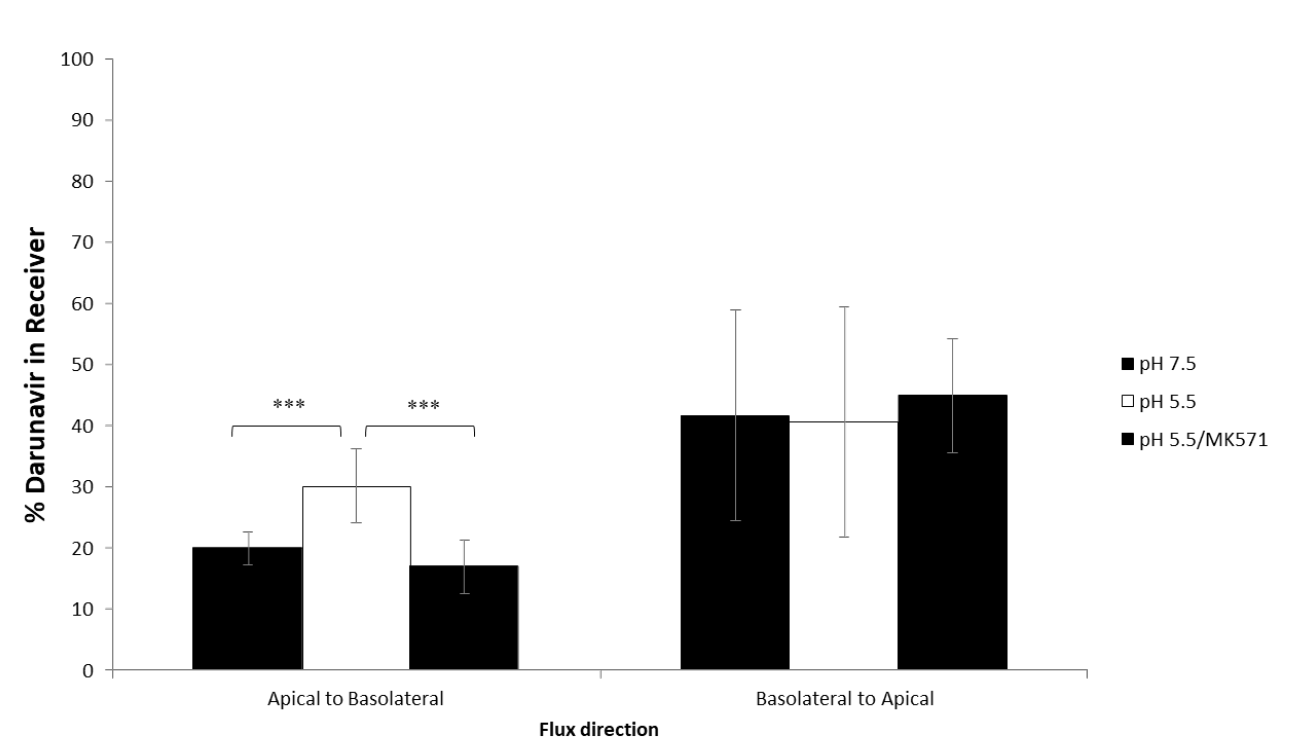
Figure 3. Transcellular permeability of darunavir across an HEC-1A monolayer cultured at pH 7.5 or pH 5.5. The apical to basolateral and basolateral to apical permeability of darunavir across HEC-1A monolayers cultured at pH 7.5 or 5.5 in the apical compartment is shown. The apical to basolateral and basolateral to apical permeability of darunavir in the presence of the MK571 inhibitor across HEC-1A monolayers cultured at pH 5.5 is shown in comparison with permeability at pH 7.5 or 5.5 without inhibitor. Data is presented as % applied darunavir permeated into the receiver chamber as the mean ± SD ( n = 10). Statistical analysis performed was a one-way ANOVA using Bonferroni post-hoc test where; *** p < 0.001.